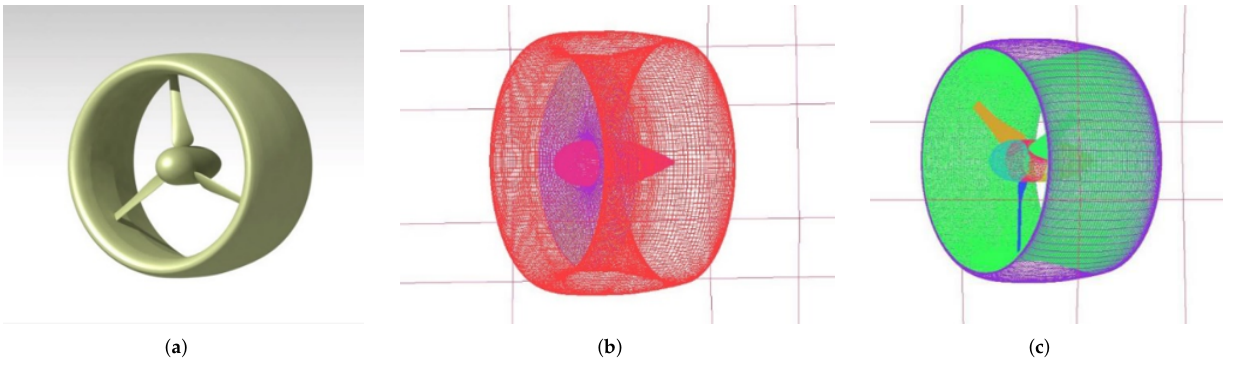
Figure 2. The NASA D-995 ducted propeller. ( a ) The geometric model; ( b ) The mesh of MSM; ( c ) Hybrid